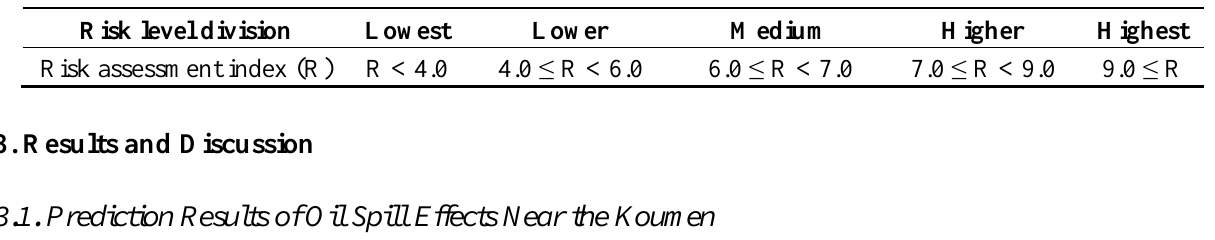
Table 2. Risk ranking of oil